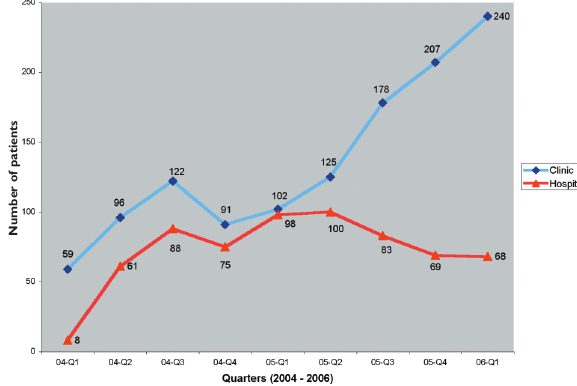
Fig. 1. Enrolment at clinics compared with hospital. (NB: this graph shows the number of patients newly enrolled into treatment for each quarter. Numbers are not